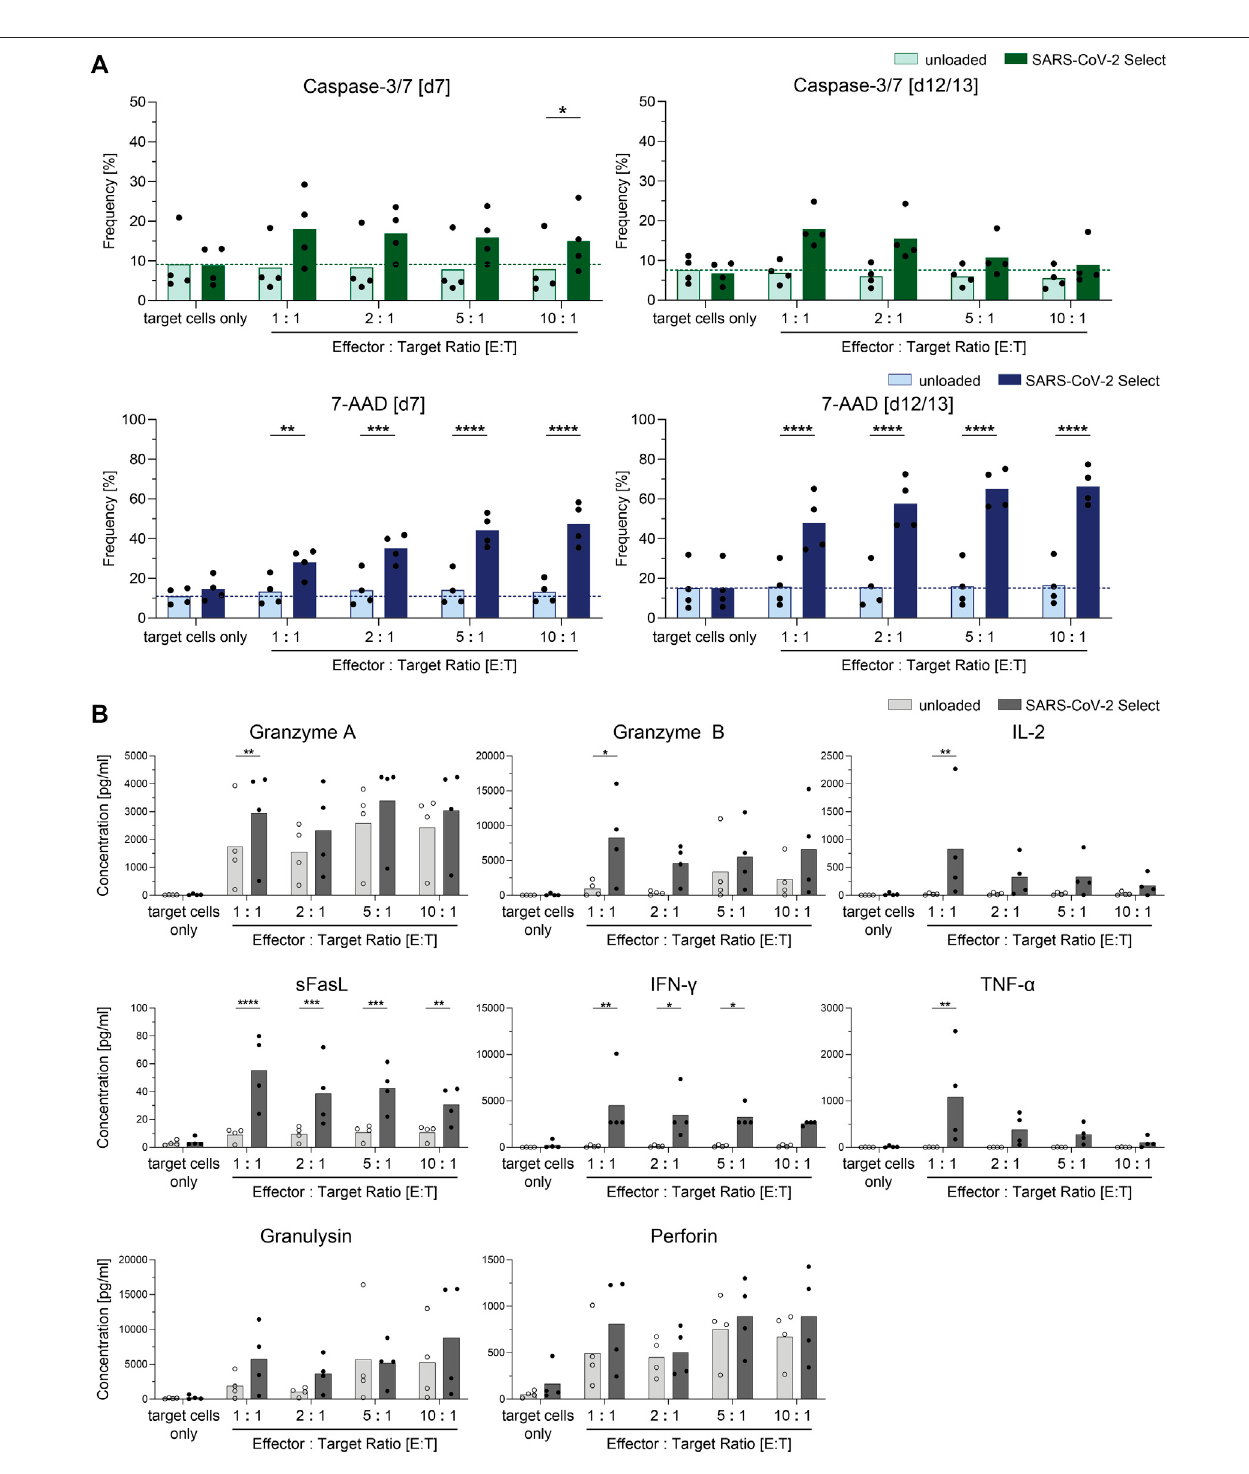
FIGURE 4 | Cytotoxic potential of clinical-grade SARS-CoV-2-speci fi c T cells ( n = 4). SARS-CoV-2-speci fi c T cells obtained by Cytokine Capture System (CCS) and CliniMACS Prodigy were expanded for 7 – 13 days and subjected to cytotoxicity assays using unloaded and SARS-CoV-2 Select-loaded autologous PBMCs as target cells. (A) Frequencies of cells with active caspase-3/7 or 7-AAD + cells among target cells (CellTrace Proliferation dye positive). Light bars: unloaded target cells. Darkbars:loadedtargetcells.Resultsaredisplayedasindividualresultsand asmeans. (B) Cellculturesupernatantsfromcytotoxicityassaysfromday 12/13were analyzedwithrespect topresence ofcytotoxic effector molecules byLEGENDPlexAssay.Results are displayed asindividual results and asmeans, n =4manufacturing processes.Statisticalsigni fi cancewascalculatedusingTwo-wayANOVAandSidak ’ smultiplecomparisonstest.* p < 0.05,** p < 0.01,*** p < 0.001,and**** p < 0.0001.